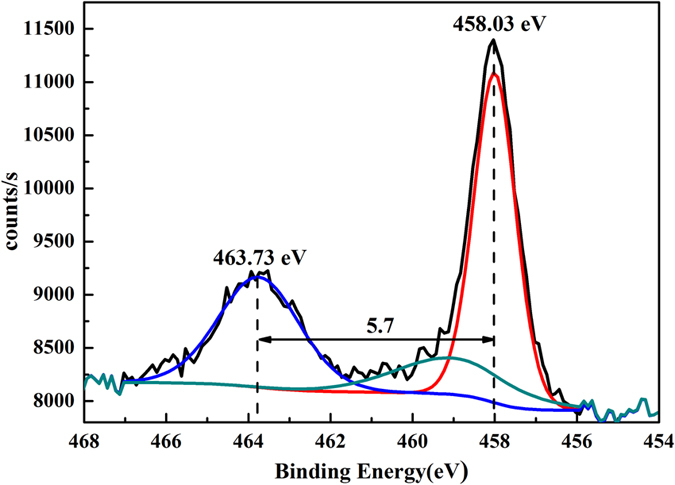
Ti2p XPS spectra of TiO2 coatings obtained from EPLSD process on the porous Ag surface.